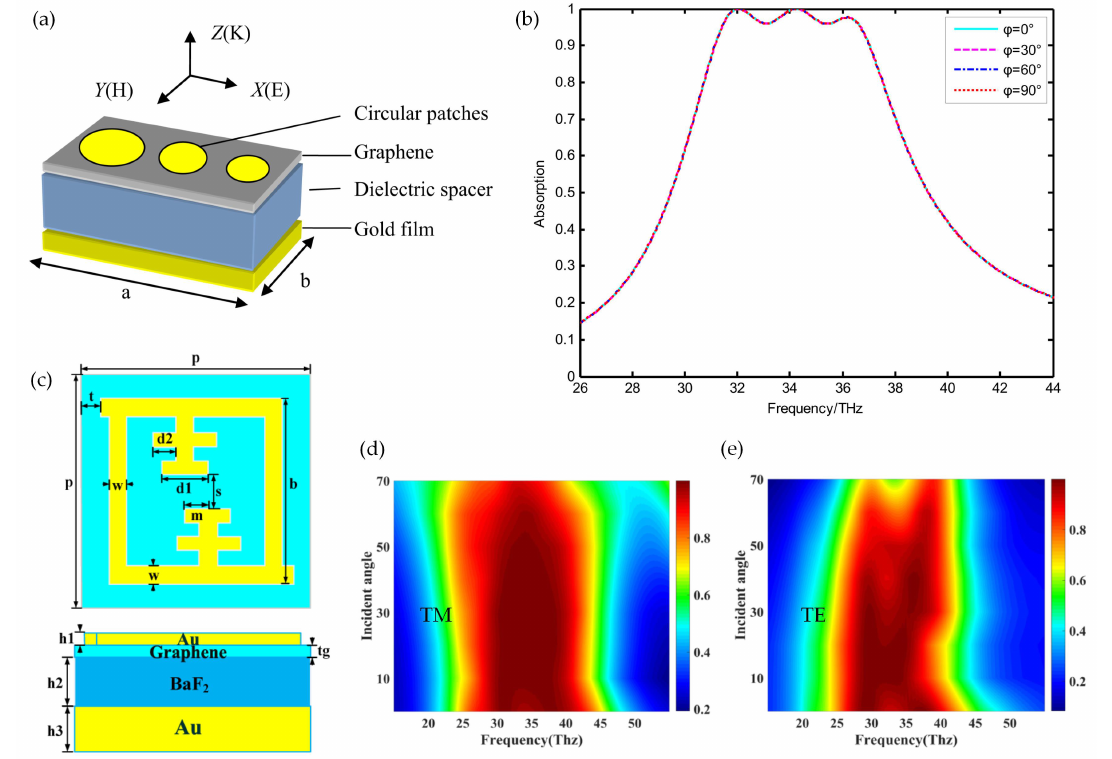
Figure 7. ( a ) unit cell of broadband graphene metasurface absorber consisting of continuous graphene and three circular metallic patches; ( b ) simulated absorption spectra with various azimuth angles ( ϕ ), reprinted with permission from Ref. [111]; ( c ) schematic of a dual electric LC (i.e., inductance (L) and capacitance (C)) unit cell; ( d ) the wave absorption vs. frequency and incident angles for transverse magnetic (TM) polarized waves; ( d ) the wave absorption vs. frequency and incident angles for transverse electric (TE) polarized waves, reprinted with permission from Ref.